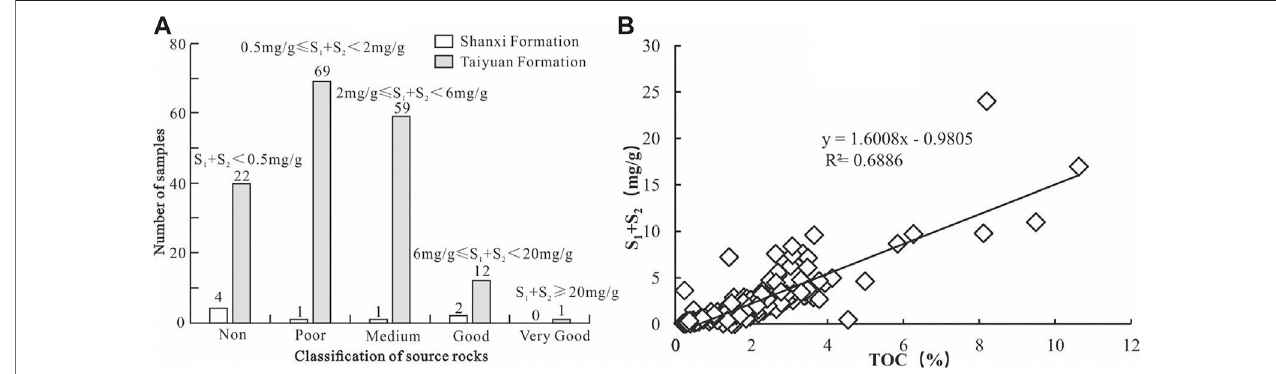
FIGURE 7 | Hydrocarbon generation potential evaluation statistics of mudshale and the relationship between them and TOC.